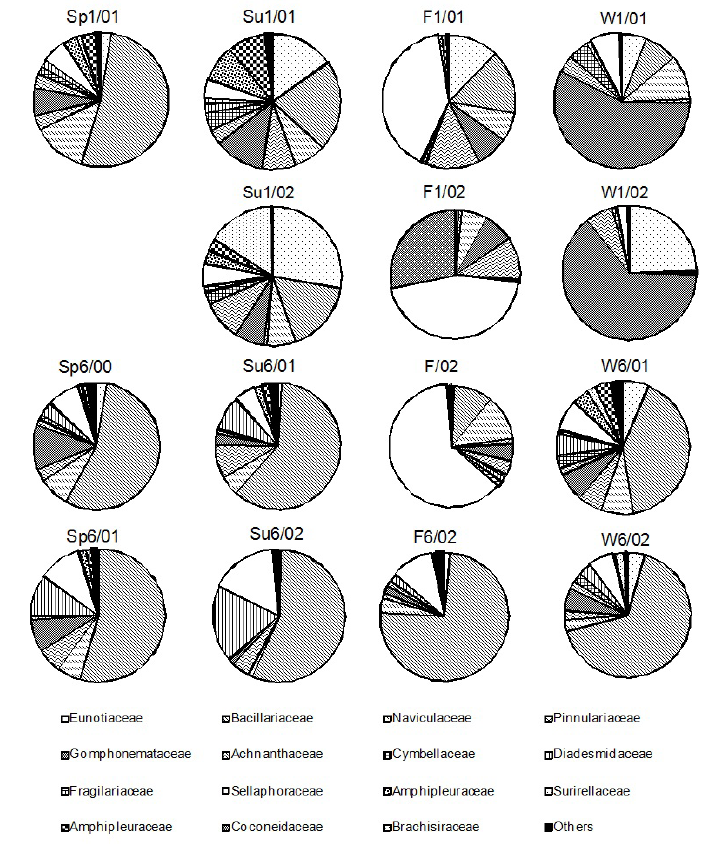
Figure 6. Temporal variation of relative abundance of the main diatom families at station 1 and station 6, correspondent to the upper and lower stretches of the Gravataí river, RS, sampled during the period of September 2000 to August 2002. (Sp = spring; Su = summer; F = fall; W = winter). The sample Sp1/02 was